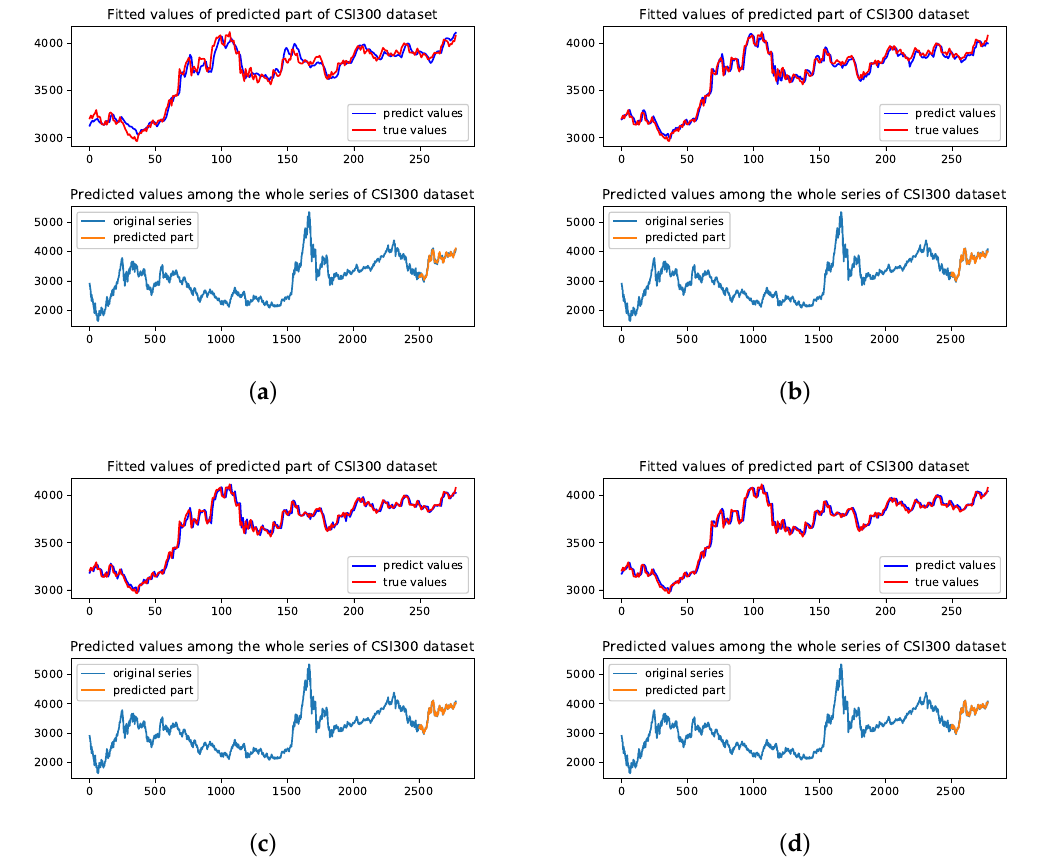
Figure 7. The visualization of the prediction results of the test part and among the whole series on the CSI300 dataset with four methods. ( a ) Predicted results of MLP model; ( b ) Predicted results of LSTM model; ( c ) Predicted results of CNN model; ( d ) Predicted results of UA